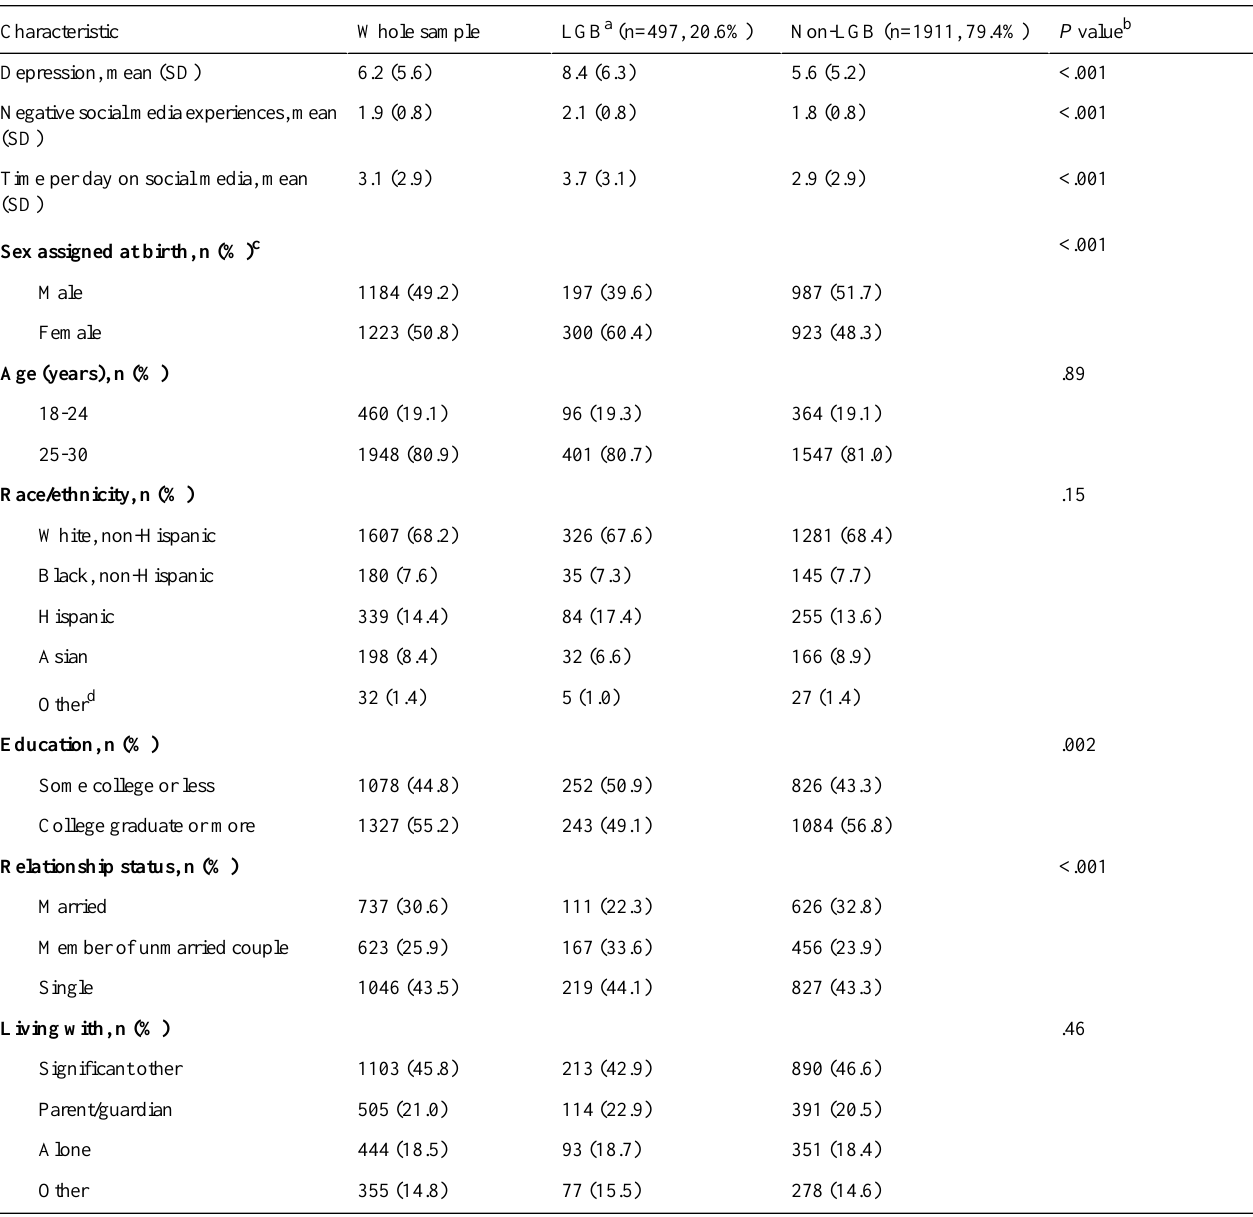
Table 1. Characteristics of the sample and associations with LGB orientation